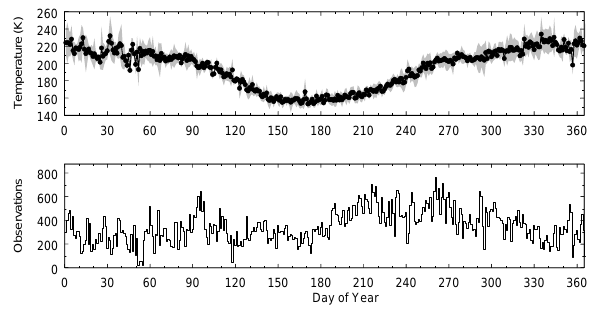
Fig. 1. The upper panel shows the seasonal changes of the meso- spheric temperature around 60 ◦ N inferred from the hydroxyl night- glow. The shaded regions show the standard error of the mean for each night. The lower panel shows the number of individual obser- vations that comprise the average temperature shown